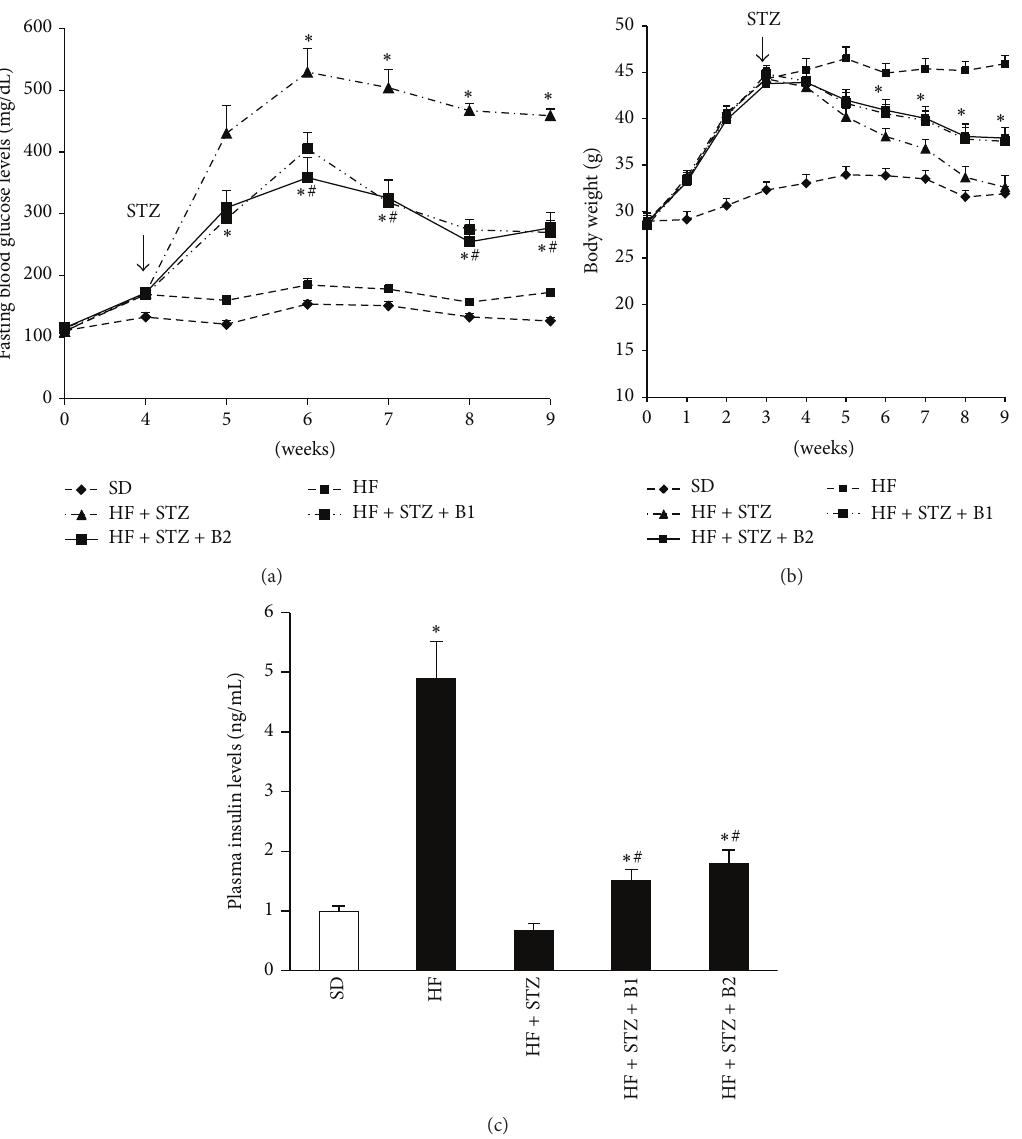
Figure 4: Dietary intake of baicalein ameliorated hyperglycemia in STZ-induced obese diabetic mice. MaleC57BL/6 mice (8mo old) were fed a HF diet containing 0, 0.25, and 0.5 g baicalein/kg diet for 4wks prior to administration of STZ (40mg/kg for 3 days) and continued on the same diet for 5wks. Aged-matched mice were fed a SD diet. Nonfasting blood glucose and (a) body weight (b) were monitored every wk after injection of STZ. Plasma insulin levels (c) in fasted mice were measured by ELISA. Data are means ± SE ( 𝑛 = 10 mice/group). ∗ 𝑃 < 0.05 versus HF + STZ group, # 𝑃 < 0.05 versus SD group. SD: standard diet, HF: high-fat diet, B1: 0.25 g baicalein/kg diet, and B2: 0.5 g baicalein/kg